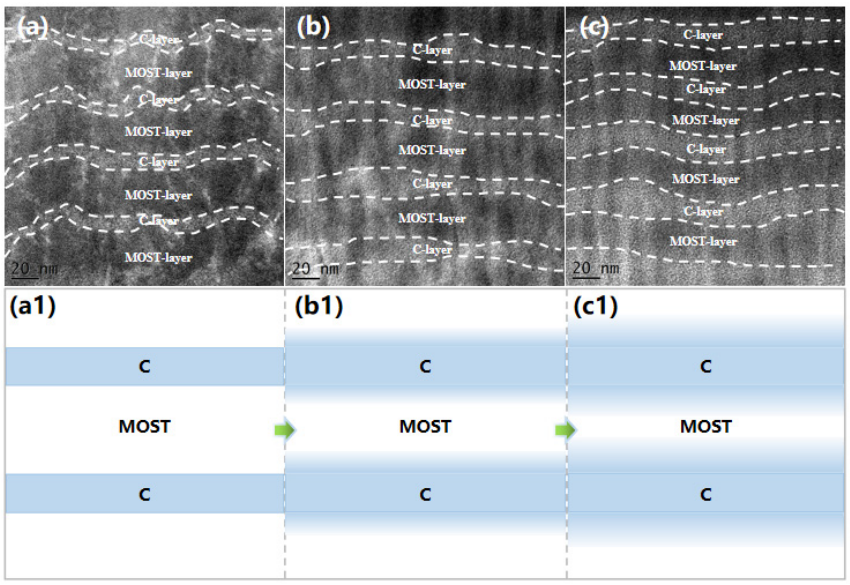
Figure 5. Cross-section TEM images and its corresponding simplified image of films with different irradiation damage degrees: ( a-a1 ) pristine, ( b-b1 ) 2 dpa, ( c-c1 ) 5 dpa.